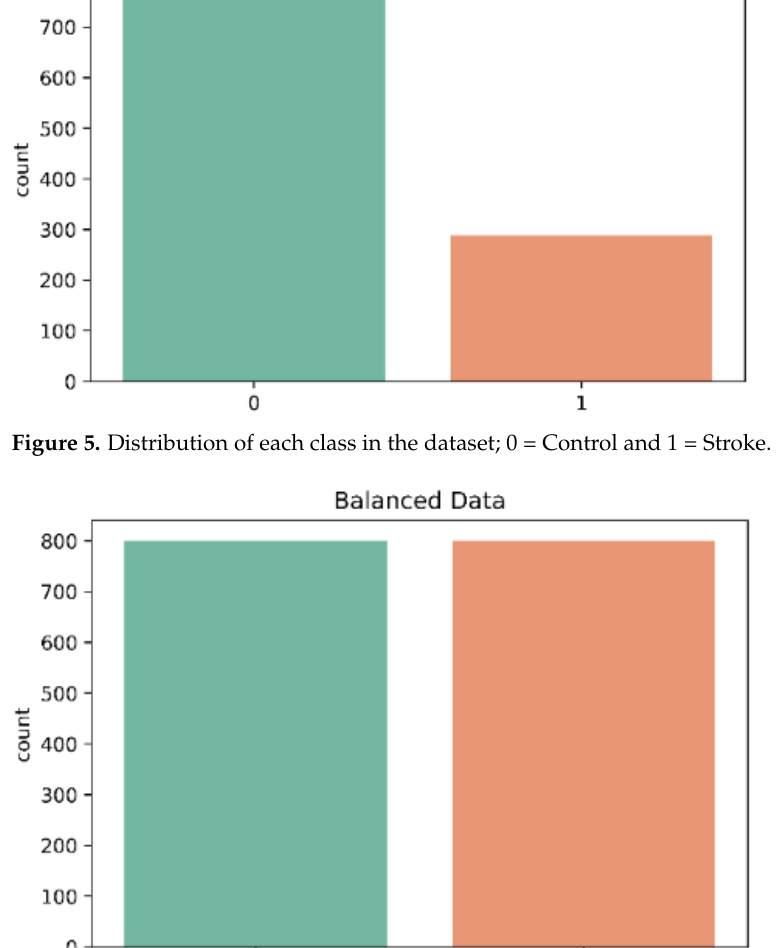
Table 7. Classification Report of the three classification models after data balancing (Borderline- SMOTE).